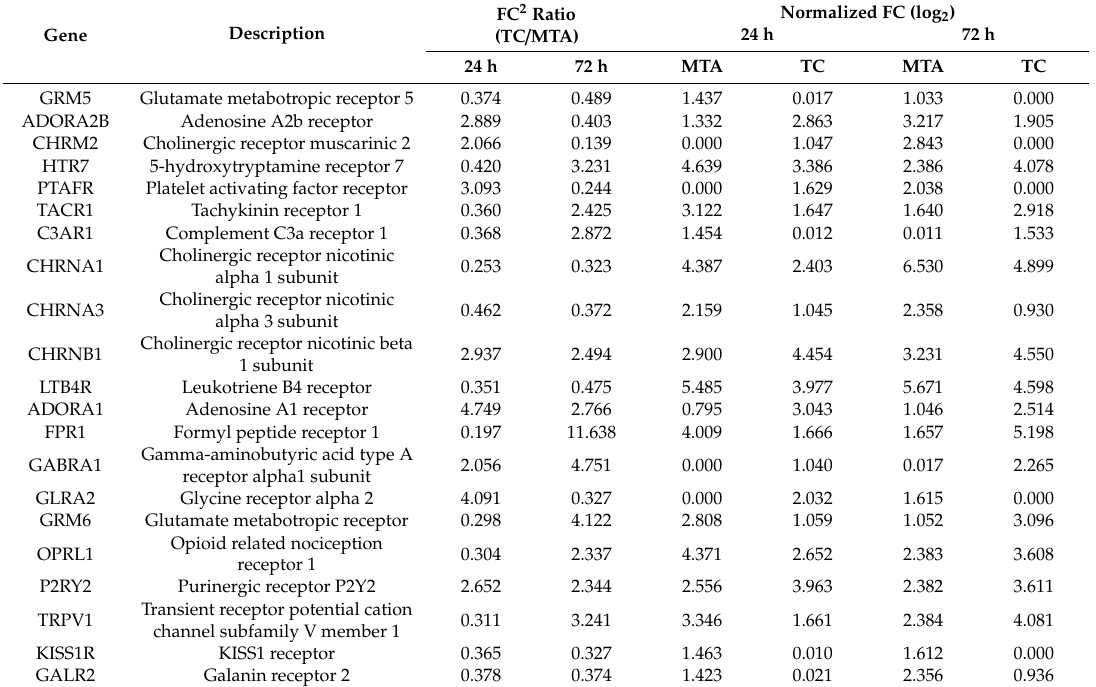
Table A1. DEGs involved in neuroactive ligand–receptor interaction in TC for 24 h and 72